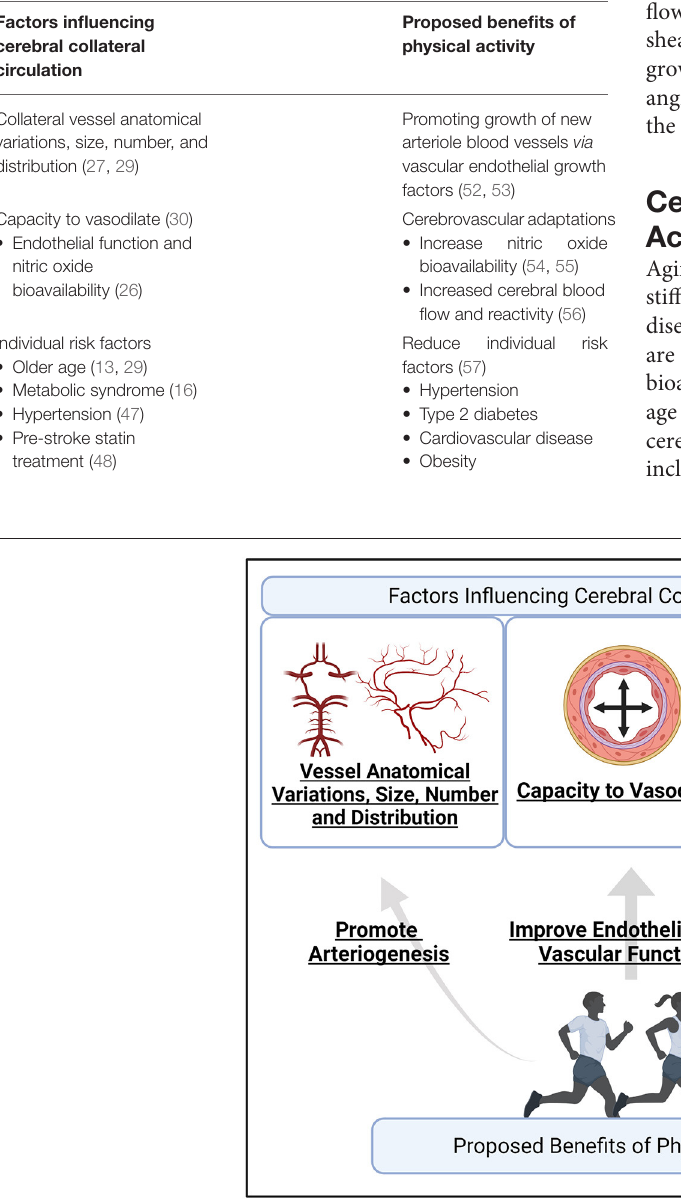
TABLE 1 | Potential association between physical activity and cerebral collateral circulation recruitment.